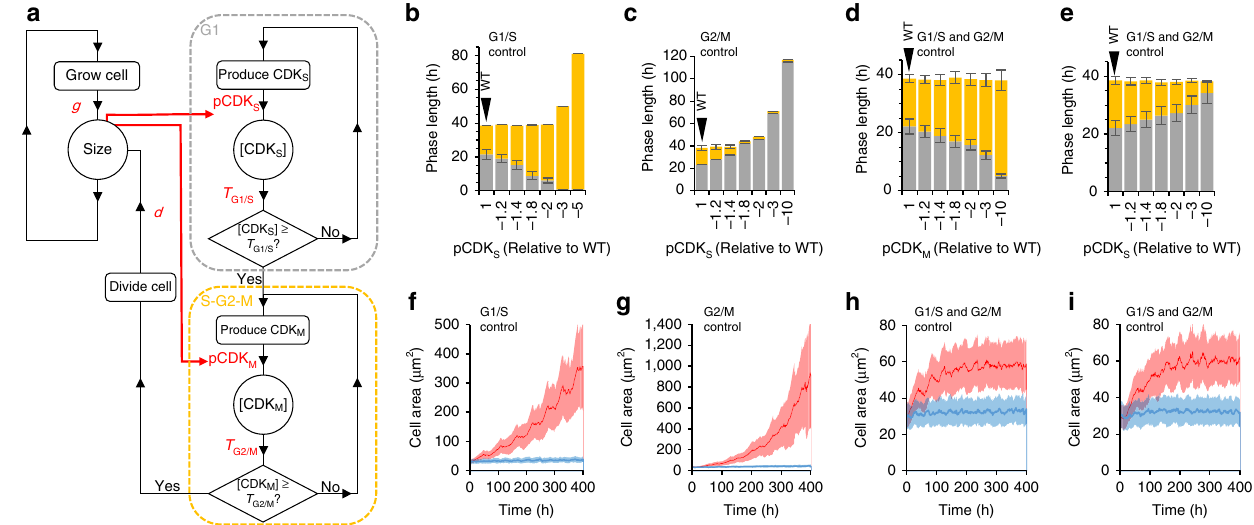
Figure 6 | Homeostasis of cell size is more robust if cell size is integrated at both the G1/S and G2/M transitions resulting in two phases with flexible lengths. ( a ) Schematic of the two-transition model of the cell cycle based on two sequential CDK activities. The cell grows with a relative growth rate g . The G1/S transition is regulated by the accumulation of CDK S activity at the rate pCDK S to a threshold T G1/S . The G/M transition is regulated by the accumulation of CDK M activity at a rate pCDK M to a threshold T G2/M . Once the G2/M transition is passed cell division is triggered and the cell divides with a division ratio d . Simulations were initiated with a population of 100 asynchronous cells and observed variation in g and d were included. ( b ) Model with size controlled at only the G1/S transition. Mean G1 length (grey) and S-G2-M length (yellow) are shown. Error bars show s.d. G1 length is determined by a combination of pCDK S and cell size, but S-G2-M length is determined solely by pCDK M . Small reductions in pCDK M (up to 2 fold) do not affect overall cell cycle length since increased S-G2-M length is compensated for by reduced G1 length. Larger reductions in pCDK M cannot be compensated, since G1 length reaches a minimum and cell cycle length is determined entirely by pCDK M . ( c ) Model with size controlled at G2/M only. Mean G1 (grey) and S-G2-M (yellow) length are shown. Error bars show s.d. S-G2-M length is determined by a combination of pCDK M and cell size. G1 length is determined solely by pCDK S . Small reductions in cell pCDK S (up to 1.4 fold) do not affect mean cell cycle length since small increases in G1 length are compensated for by